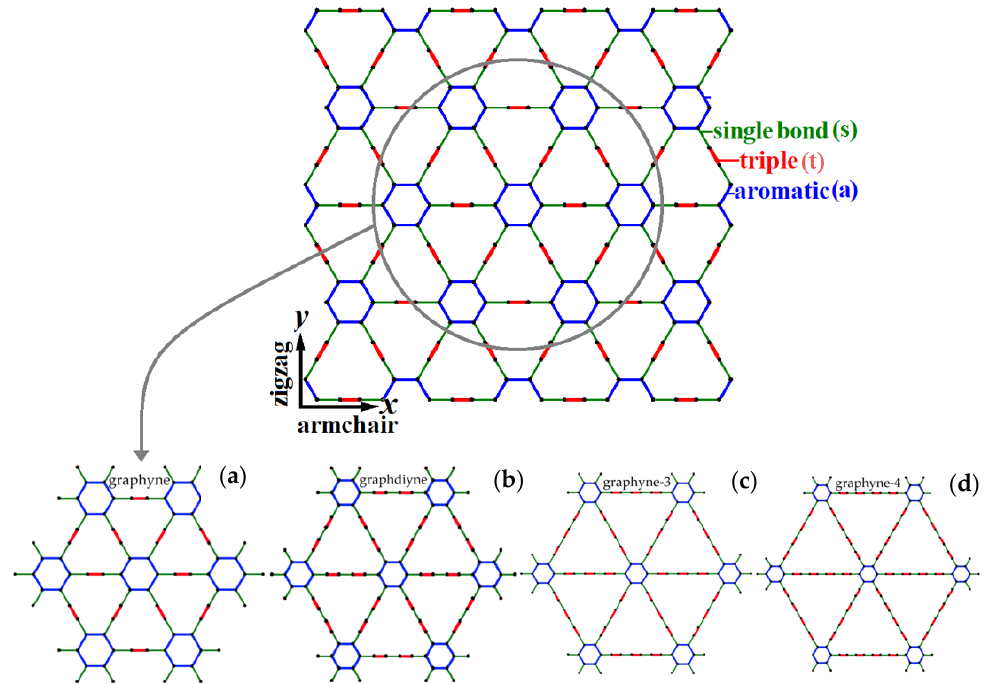
Figure 1. The structural geometry graphyne, graphdiyne, graphyne-3, and graphyne-4.